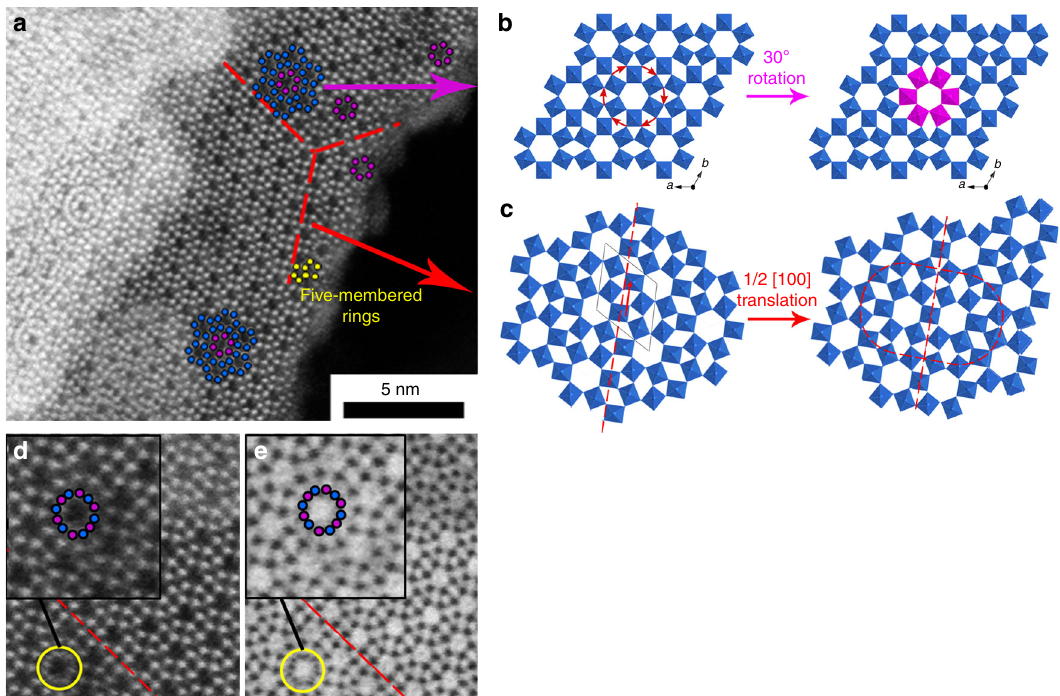
Fig. 2 Crystal defects in the h ’ -WO 3 framework. The study has been performed on the bronze recovered directly after aqueous synthesis. a STEM-HAADF micrograph showing in yellow fi ve-membered (WO 6 ) 5 rings where one octahedra has been removed from a (WO 6 ) 6 wheel, b 30°-rotation of (WO 6 ) 6 wheels around the c axis (purple), c antiphase boundaries showing displacement of the structure by a vector ½ [100] along (100) directions (red dashed lines). d STEM-HAADF and e corresponding STEM-ABF images of superimposed (WO 6 ) 6 rings rotated by 30° with respect to each